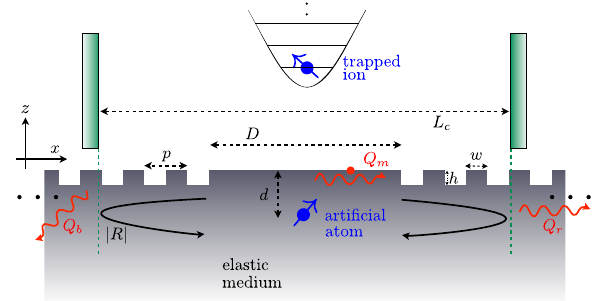
FIG. 1. SAW as a universal quantum transducer. Distributed Bragg reflectors made of grooves form an acoustic cavity for surface acoustic waves. The resonant frequency of the cavity is v = 2 p . Reflection occurs determined by the pitch p , f c ¼ s effectively at some distance inside the grating; the fictitious mirrors above the surface are not part of the actual experimental setup, but are shown for illustrative purposes only. Red arrows indicate the relevant decay channels for the cavity mode: leakage through the mirrors, internal losses due to, for example, surface imperfections, and conversion into bulk modes. Qubits inside and outside of the solid can be coupled to the cavity mode. In more complex structures, the elastic medium can consist of multiple layers on top of some